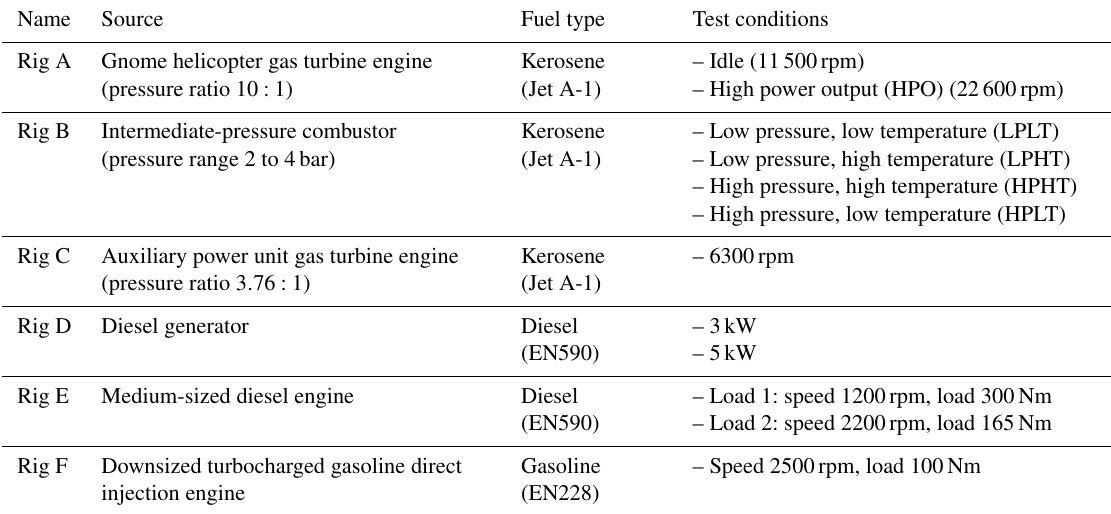
Figure 1. Schematic diagram of the experimental set-up, illustrated for Rig A. Table 1. Test rigs and operating